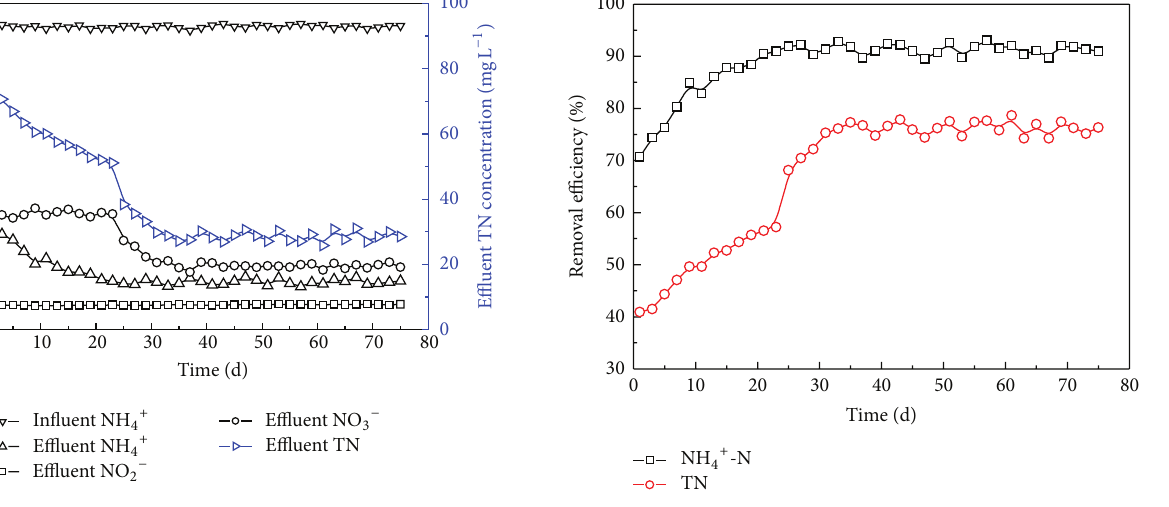
Figure 4: NH 4+ and TN removal efficiency in the startup and steady run